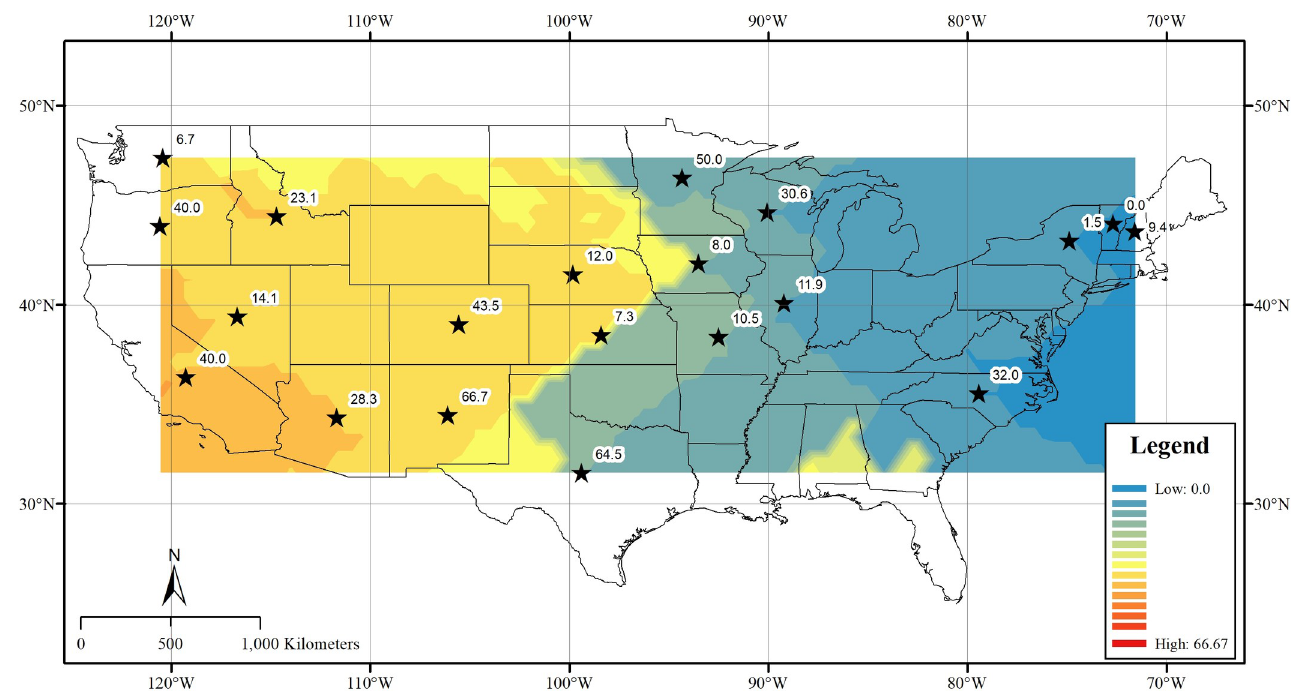
Fig 2. Geographic distribution of collection-state assignments of molt origin among all European starlings ( N = 686) collected at U.S. dairies and feedlots. For each state associated with this study, the predicted surface represents the log-transformed percentage of samples assigned to the state in which the sample was